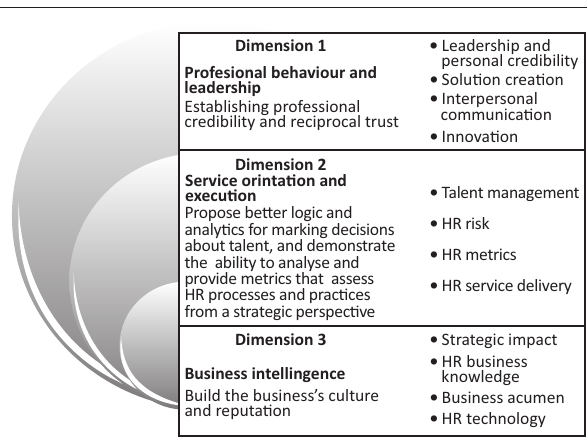
FIGURE 2: Validated human resource professional competence